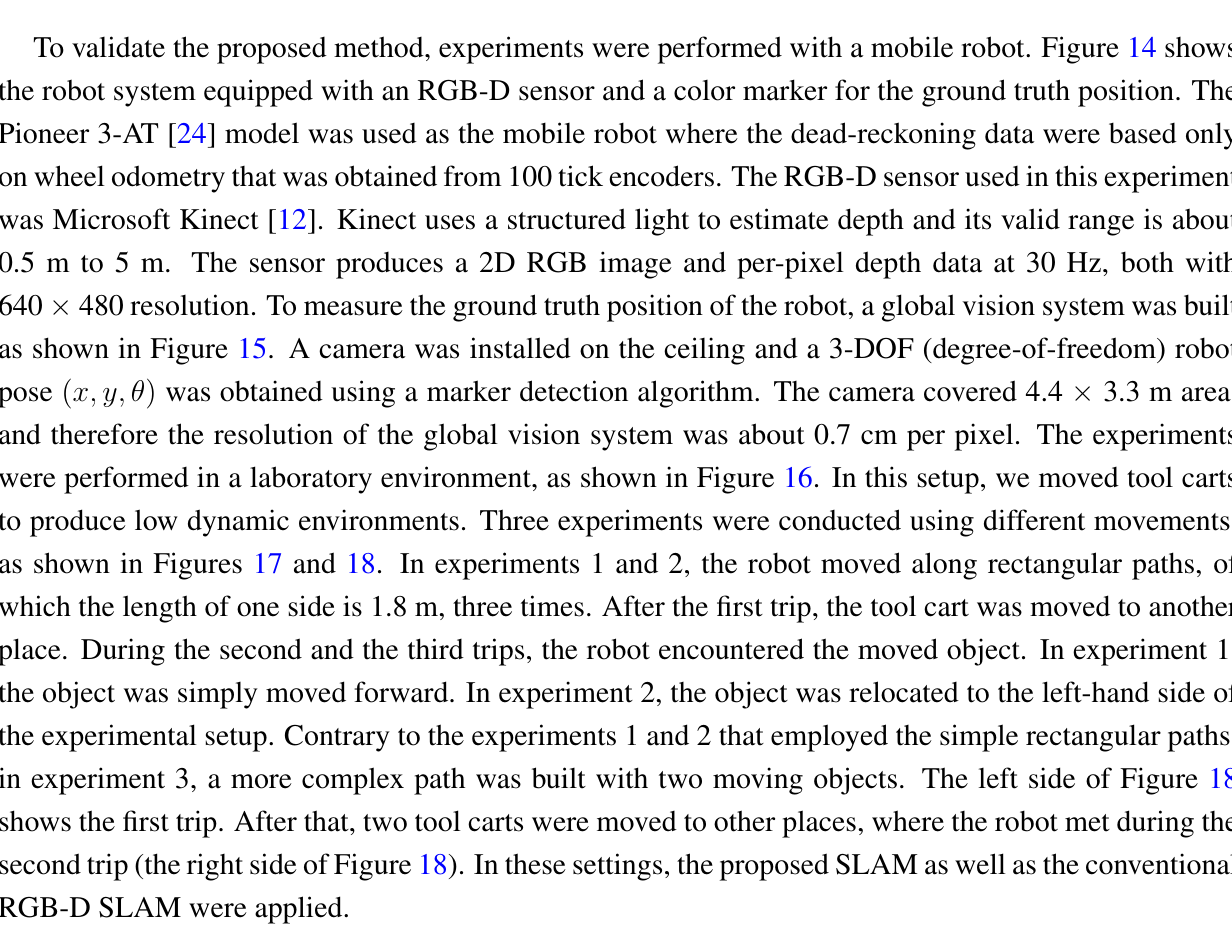
Figure 14. Mobile robot system with an RGB-D sensor and a marker for measuring the ground truth